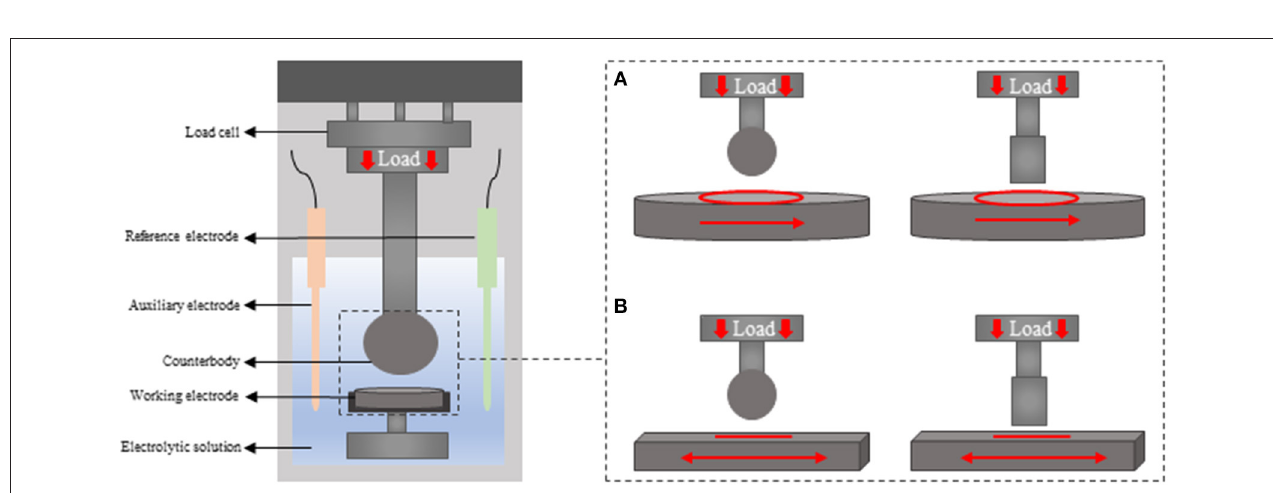
FIGURE 4 | Schematic diagram of tribocorrosion testing system (A) pin/ball on disc (unidirectional) and (B) the pin/ball on plate (reciprocating).